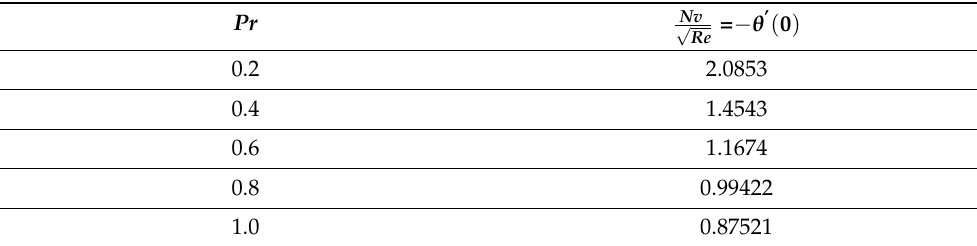
Table 2. Impact of Pr on the Nusselt number for We = 0.2; n = 2; Ec = 0.2; sc = 0.2; λ = 0.1; Nr = 1; c = 5.